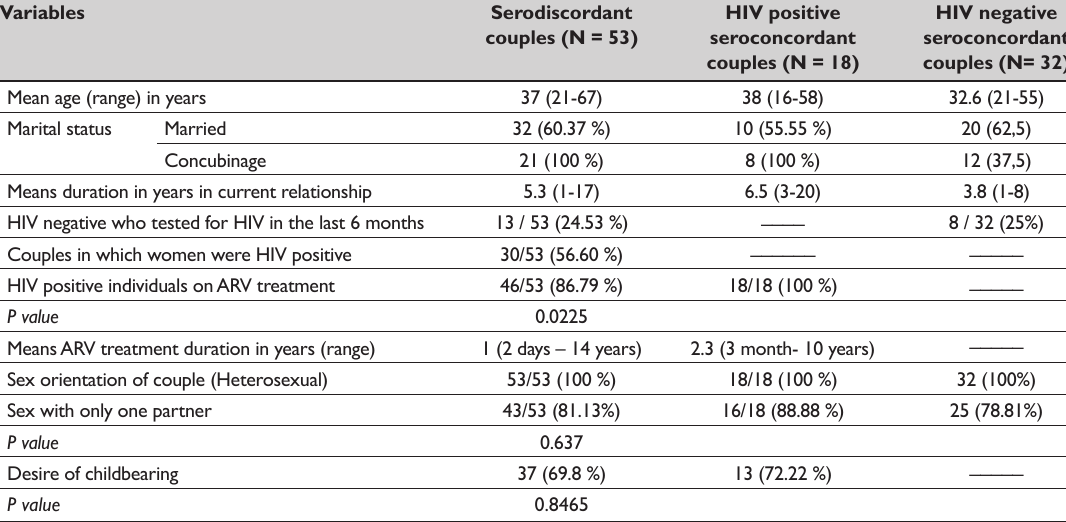
Table 1: Sociodemographic characteristic of couples